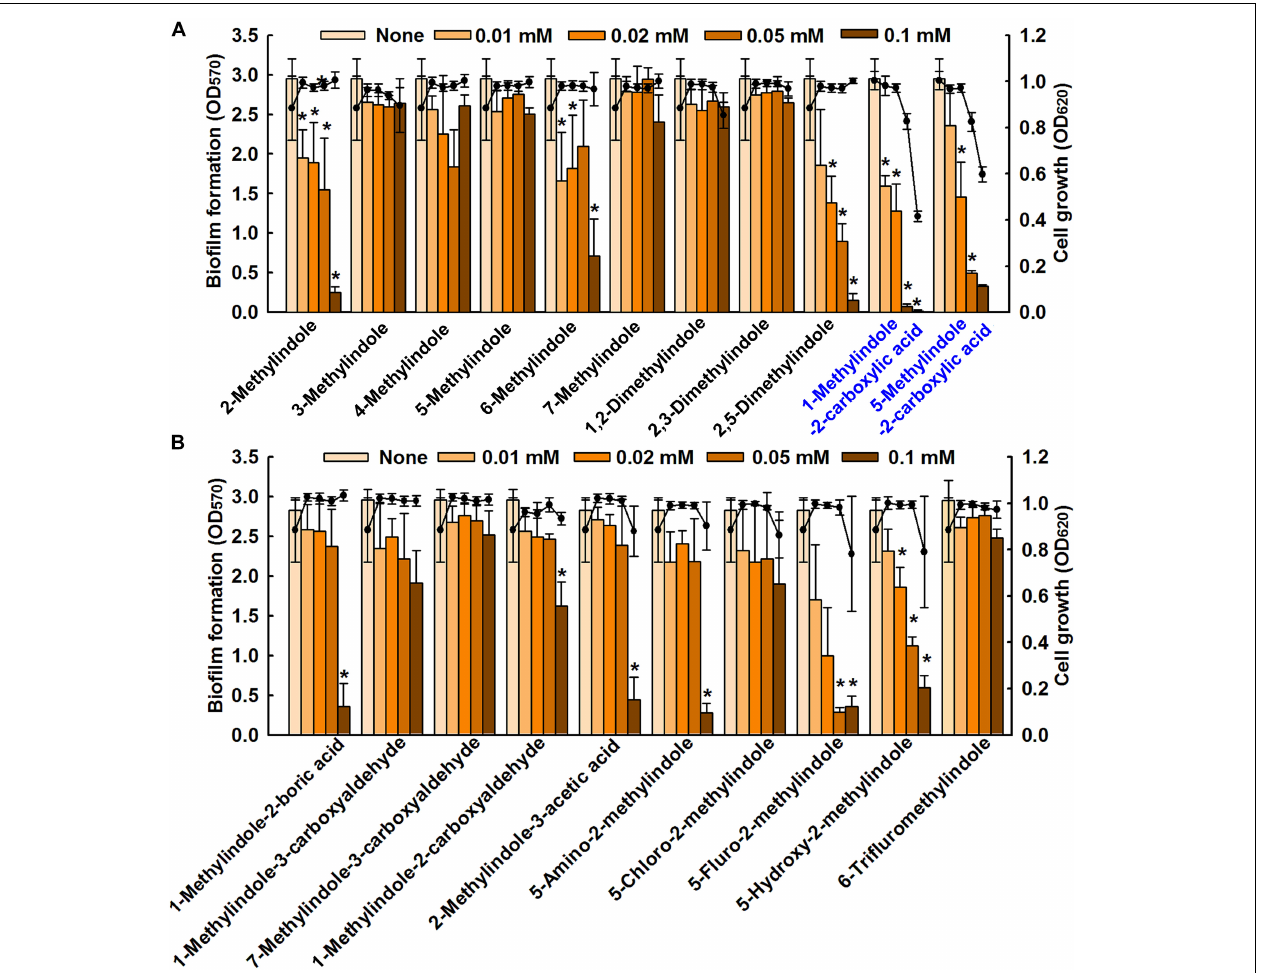
FIGURE 1 | Inhibition of biofilm formation by methylindoles. The anti-biofilm activities of 21 methylindoles against C. albicans DAY185 were examined after incubation for 24 h (A,B) . The chemical structures of methylindoles are shown in Supplementary Table S1 . At least two independent experiments were conducted (six wells per sample); error bars indicate standard deviations. ∗ p < 0.05 vs. untreated controls. Bars indicate biofilm formation and lines indicate planktonic cell